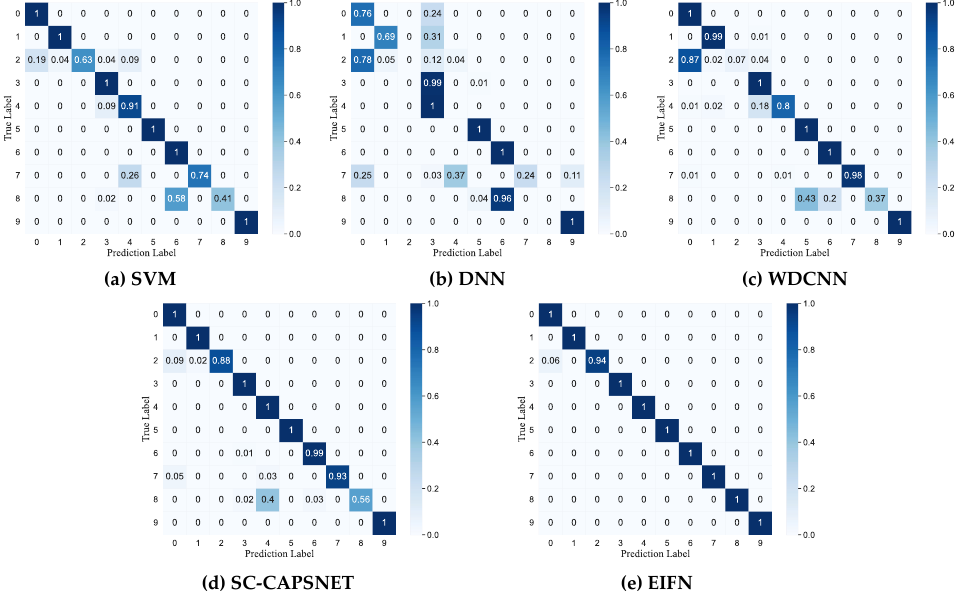
Figure 9. The confusion matrix of diagnostic accuracy on CWRU. The abscissa is the prediction label, and the ordinate is the real label.